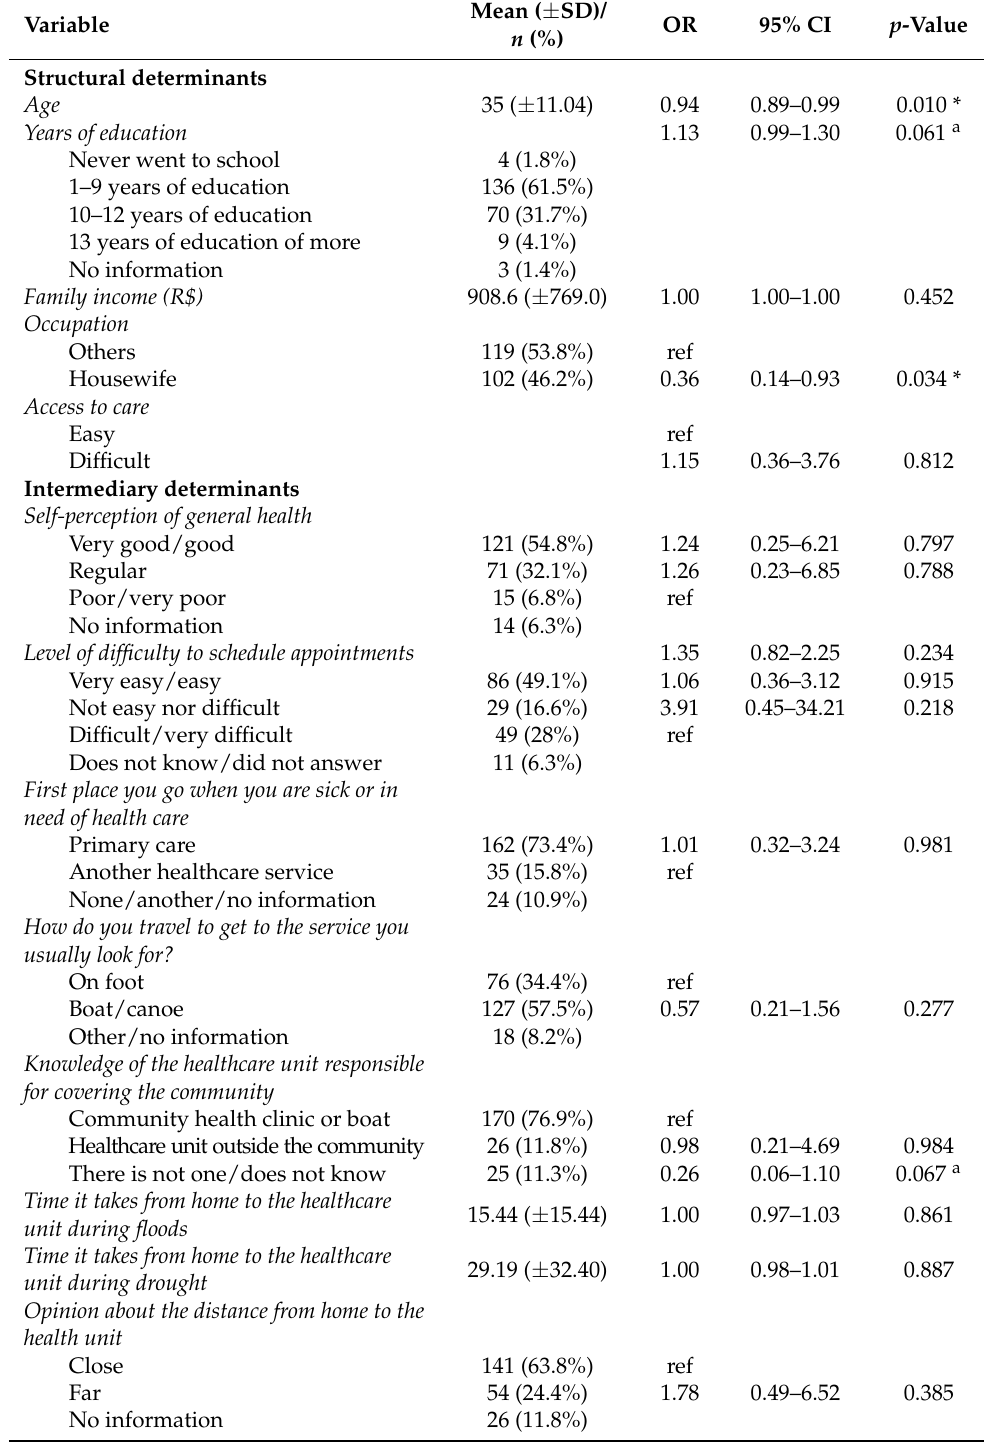
Table 2. Description of independent variables and unadjusted odds ratios for not performing cervical screening in the past three years in women aged 25 to 59 years.